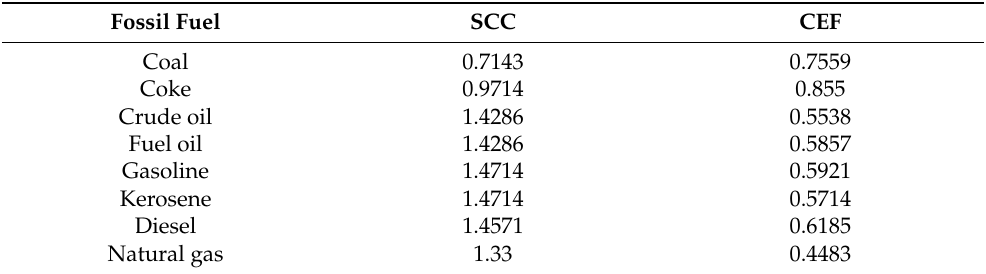
Table 1. Standard coal coefficient (SCC) and carbon emission coefficient (CEF) of eight fossil energy sources. Fossil